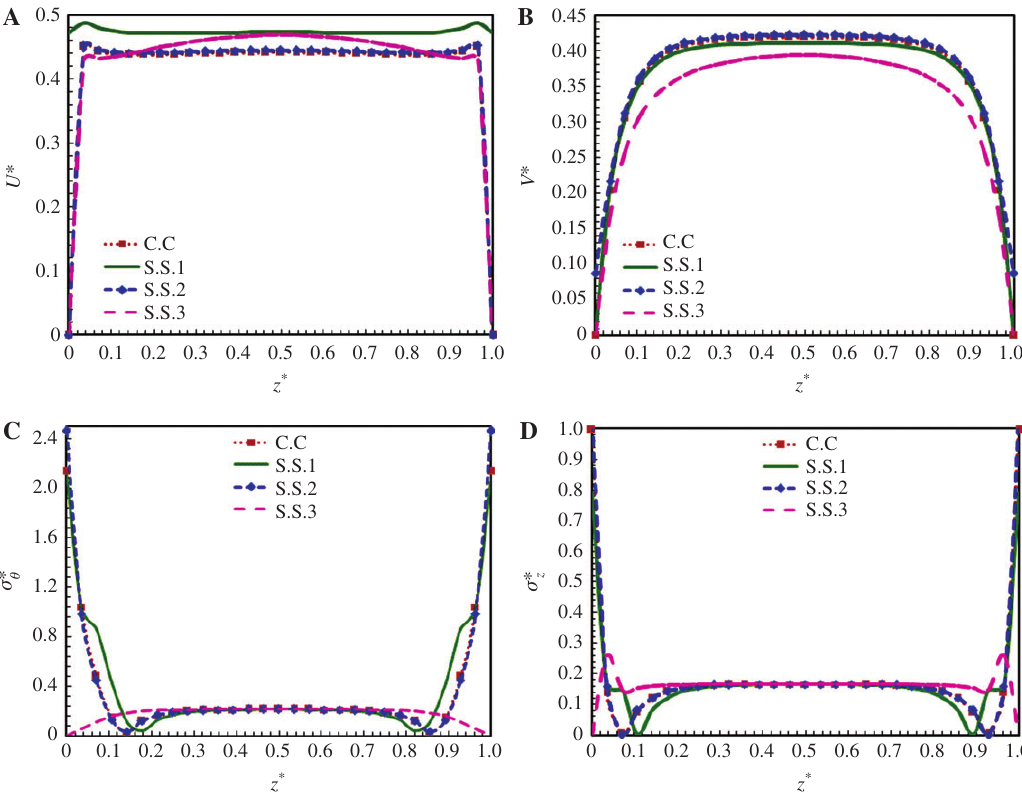
Figure 7 Distributions of non-dimensional (A) radial displacement, (B) tangential displacement (C) tangential stress and (D) axial stress along the length of the cylinder at the inner surface and t * = 1 for different boundary conditions.